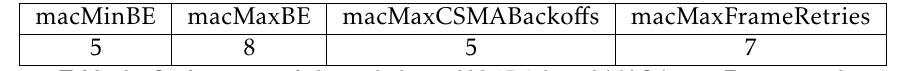
Table 2. Configuration of the underlying 802.15.4-based MAC layer; Experiment 2